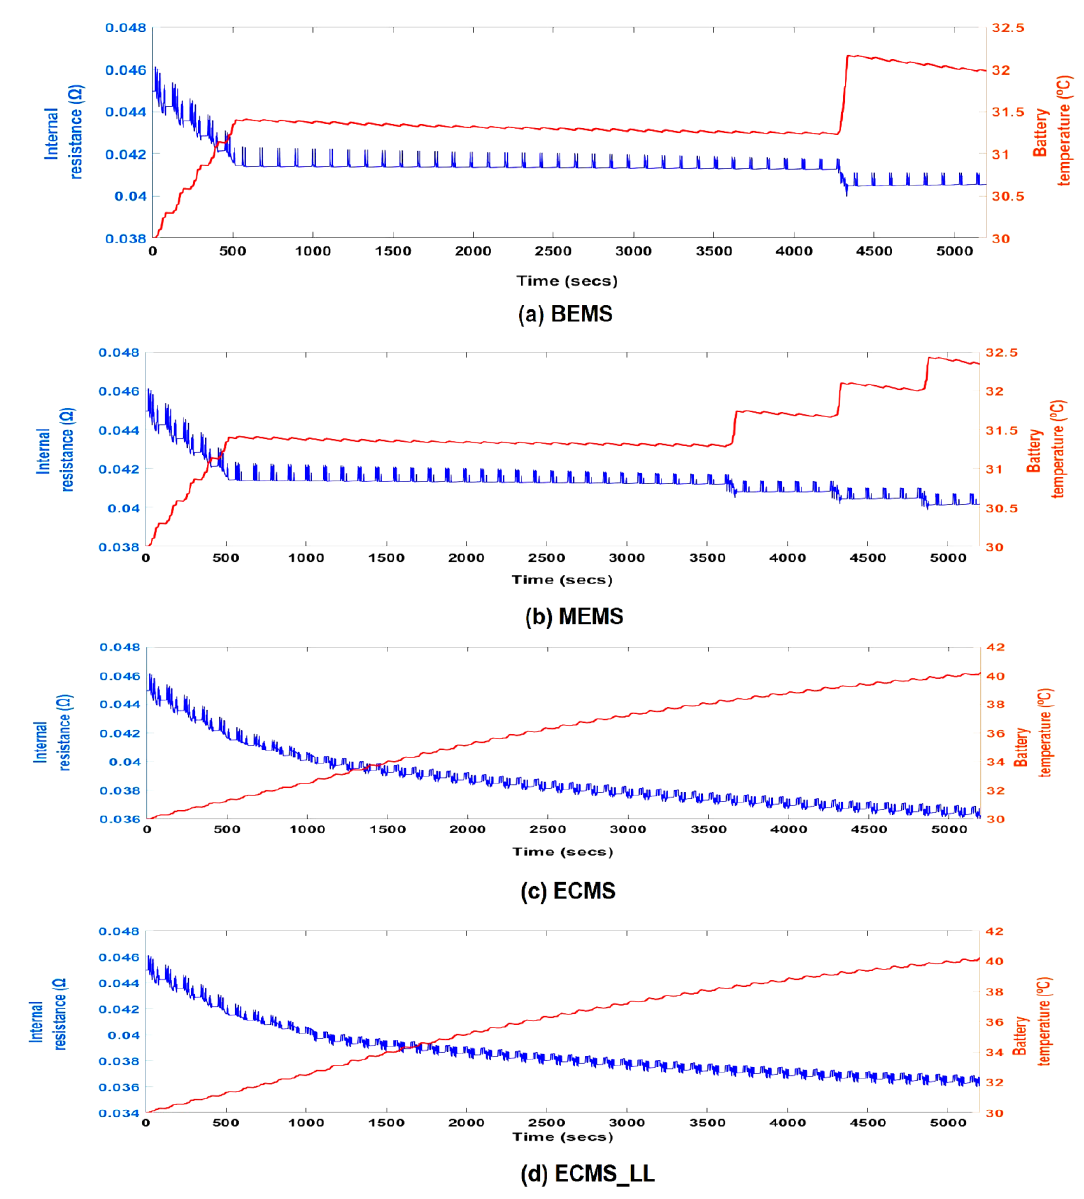
Figure 10. Battery internal resistance and temperature profiles for Veh 1 configuration tested for the IDC test cycle: ( a ) BEMS, ( b ) MEMS, ( c ) ECMS and ( d )